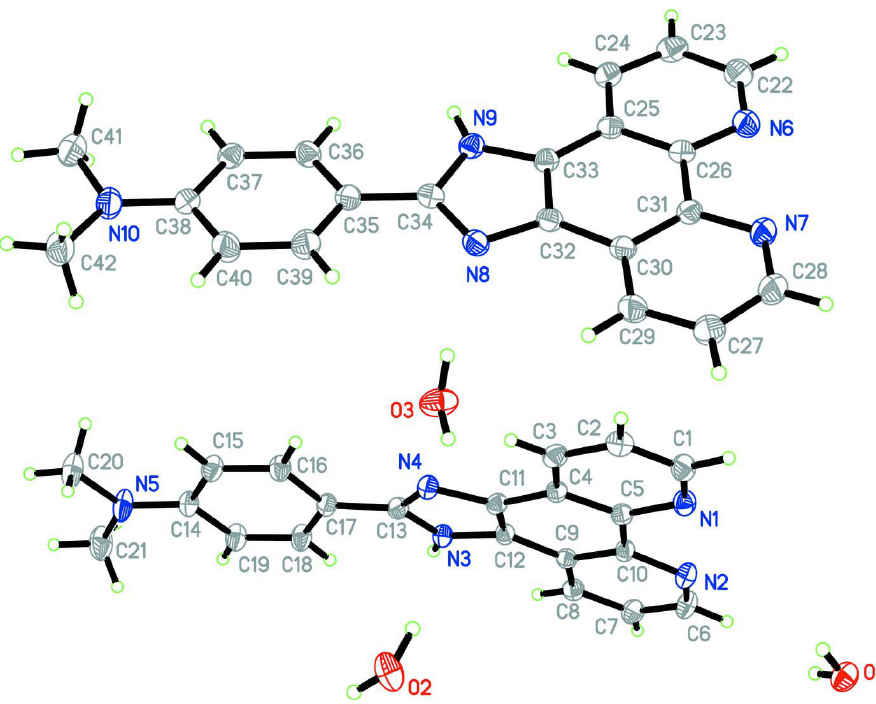
A view of the compound with the atomic numbering scheme. Displacement ellipsoids were drawn at the 30% probability